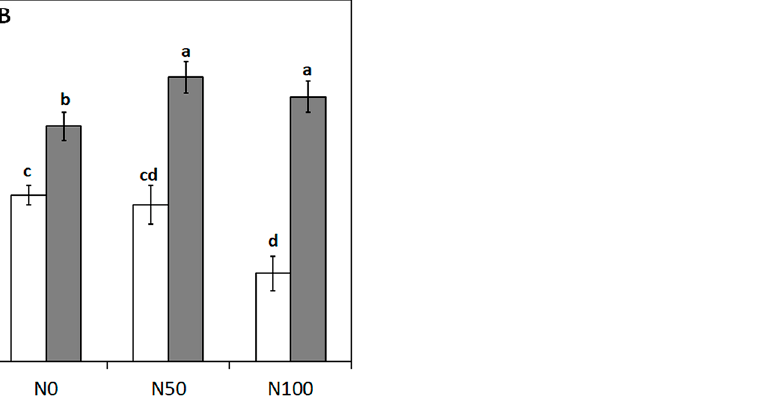
Figure 2. Effect of N rate on hue angle ( A ) and electrolyte leakage ( B ) in fresh and stored butterhead lettuce. Vertical bars (standard error) (n = 24) with different letters are significantly different according to the LSD test ( p = 0.05).